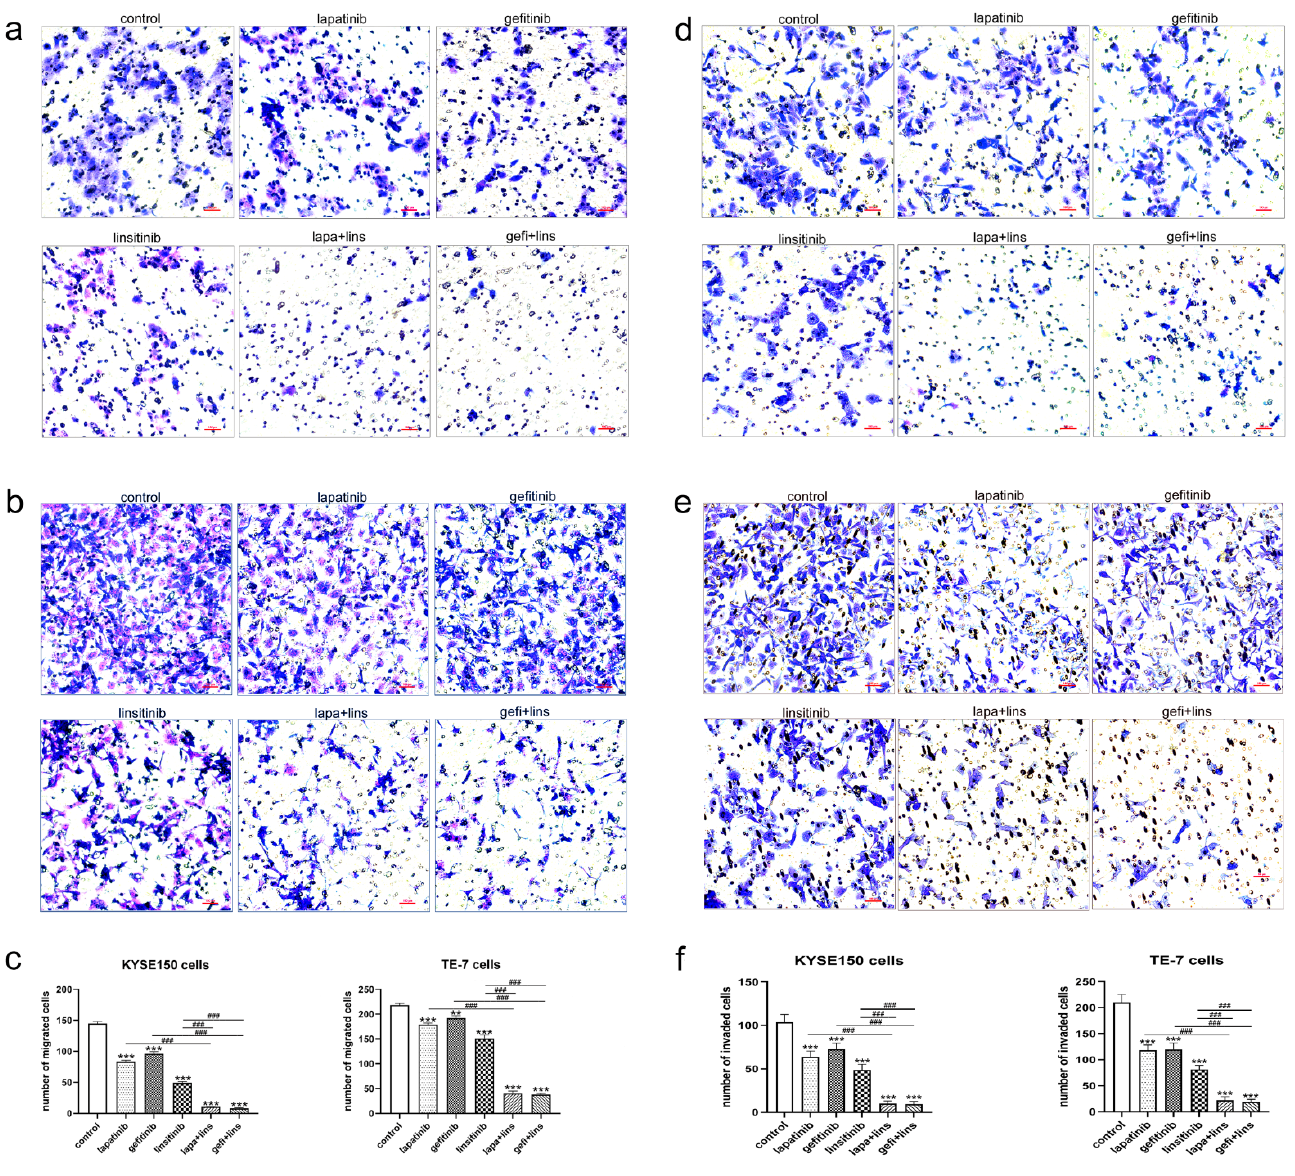
Figure 4. The effects of lapatinib, gefitinib, and linsitinib alone or in combination on the migration and invasion of KYSE150 and TE-7 cells detected by a transwell assay. ( a , b ) Representative images of KYSE150 ( a ) and TE-7 ( b ) cells that migrated from the upper chamber membrane of the transwell system. ( c ) The migrated cells from 10 random fields of view (at 200×) were counted. ( d , e ) Representative images of KYSE150 ( d ) and TE-7 ( e ) cells that invaded and migrated from the matrigel-coated upper chamber membrane of the transwell system. ( f ) The invaded and migrated cells from 10 random fields of view (at 200×) were counted. Scale bars, 100 μ m. ** p < 0.01, *** p < 0.001 vs. control. ### p < 0.001 between depicted groups.